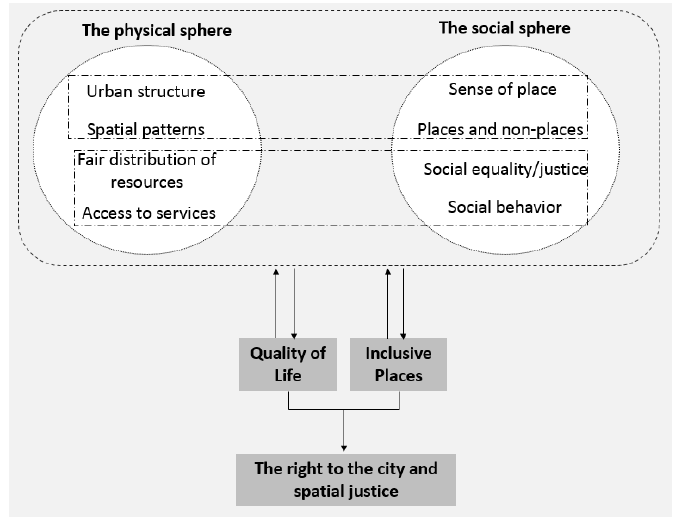
Figure 1. The physical and social spheres associated with quality of life and inclusive places guarantee the right to the city and spatial justice.